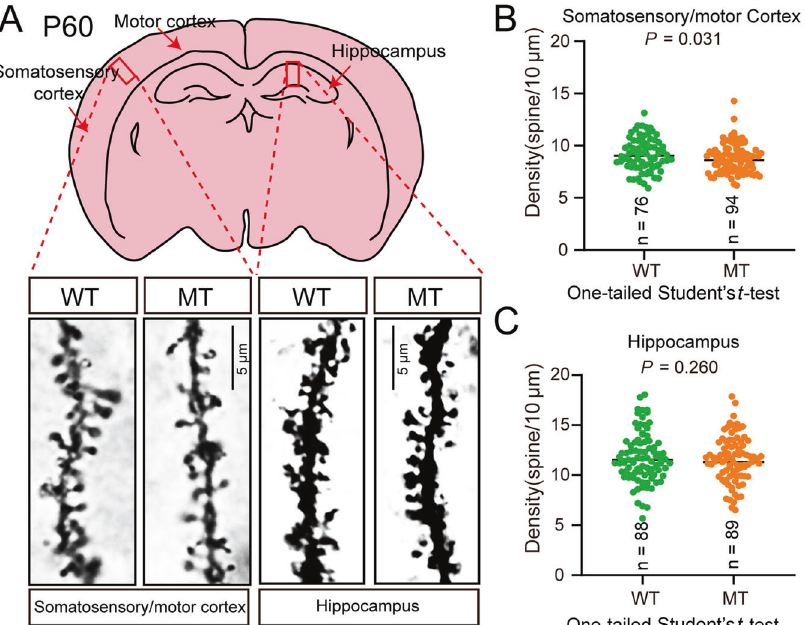
Fig. 5 SLC39A8-p.393T knock-in affected dendritic spine density. A Overview of dendritic spine analysis. B , C Dendritic spine density in cortex was signi fi cantly decreased in SLC39A8-p.393T knock-in mice compared with wild-types. One-tailed Student ’ s t - test was used for statistical test. Data represent mean ± SD, the number of neurons used for this quantitative analysis in WT and MT groups were n = 76 and n = 94 in cortex ( B ), n = 88 and n = 89 in hippocampus ( C ) (from 3 independent SLC39A8-p.393T knock-in mice and 3 SLC39A8-p.393A wild- type